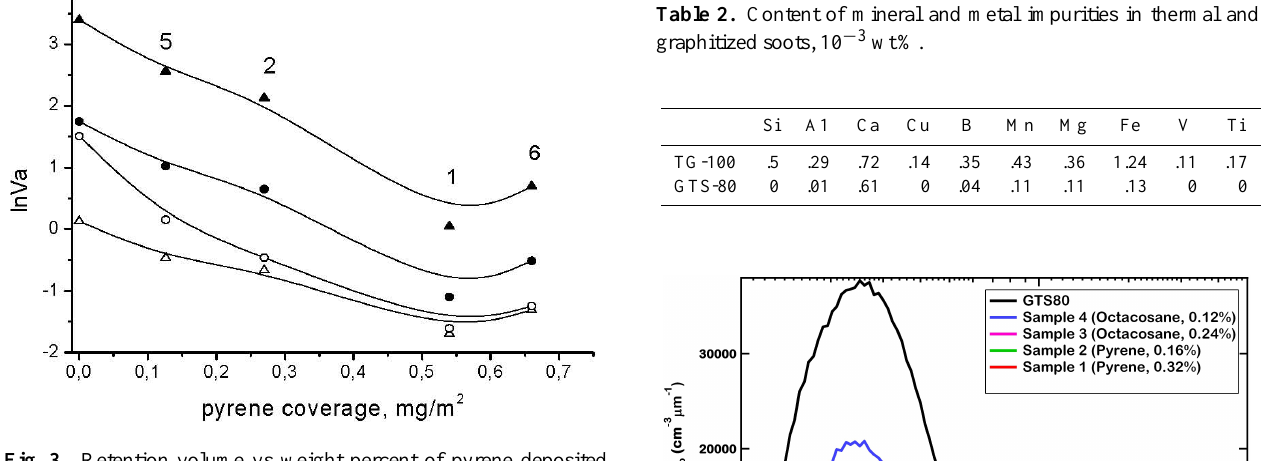
Table 2. Content of mineral and metal impurities in thermal and graphitized soots, 10 − 3 wt%.